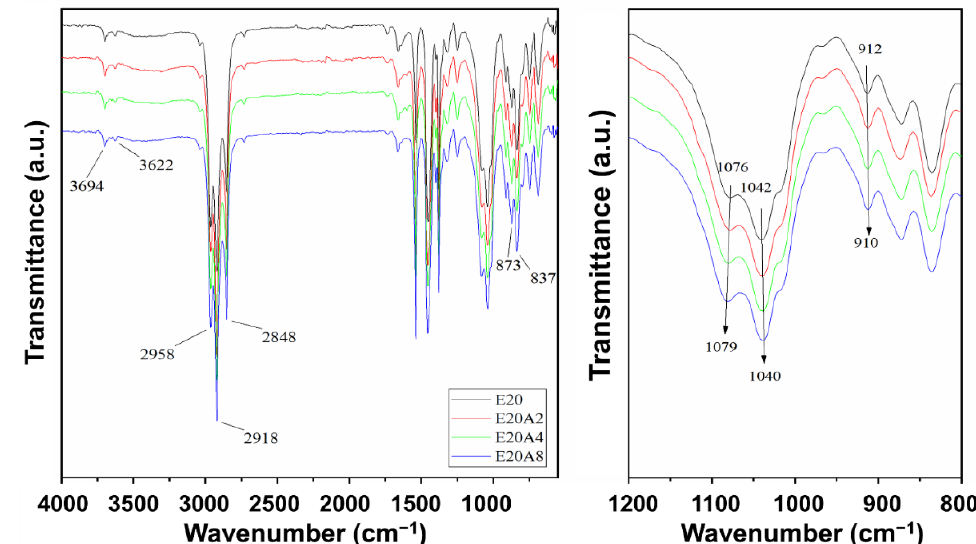
Figure 4. Infrared spectra of ENR/HNT composites filled with untreated and acid-treated HNT. Figure 5. XRD scattering patterns of HNT after various durations of acid